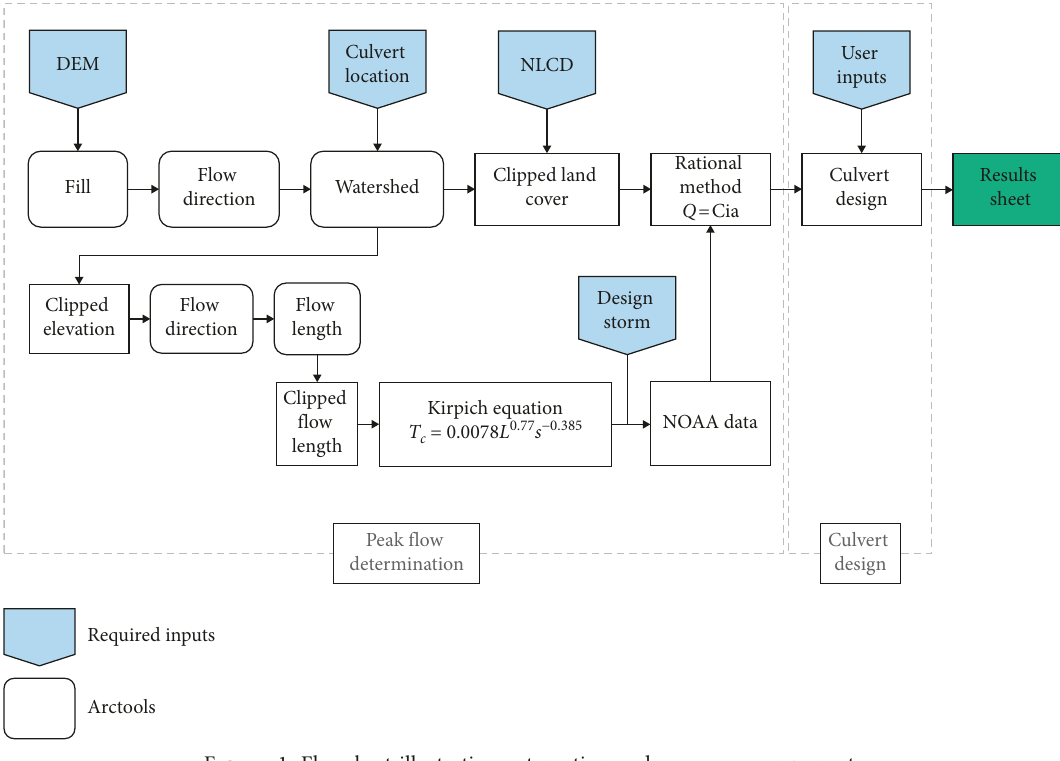
Figure 1: Flowchart illustrating automation and necessary components.